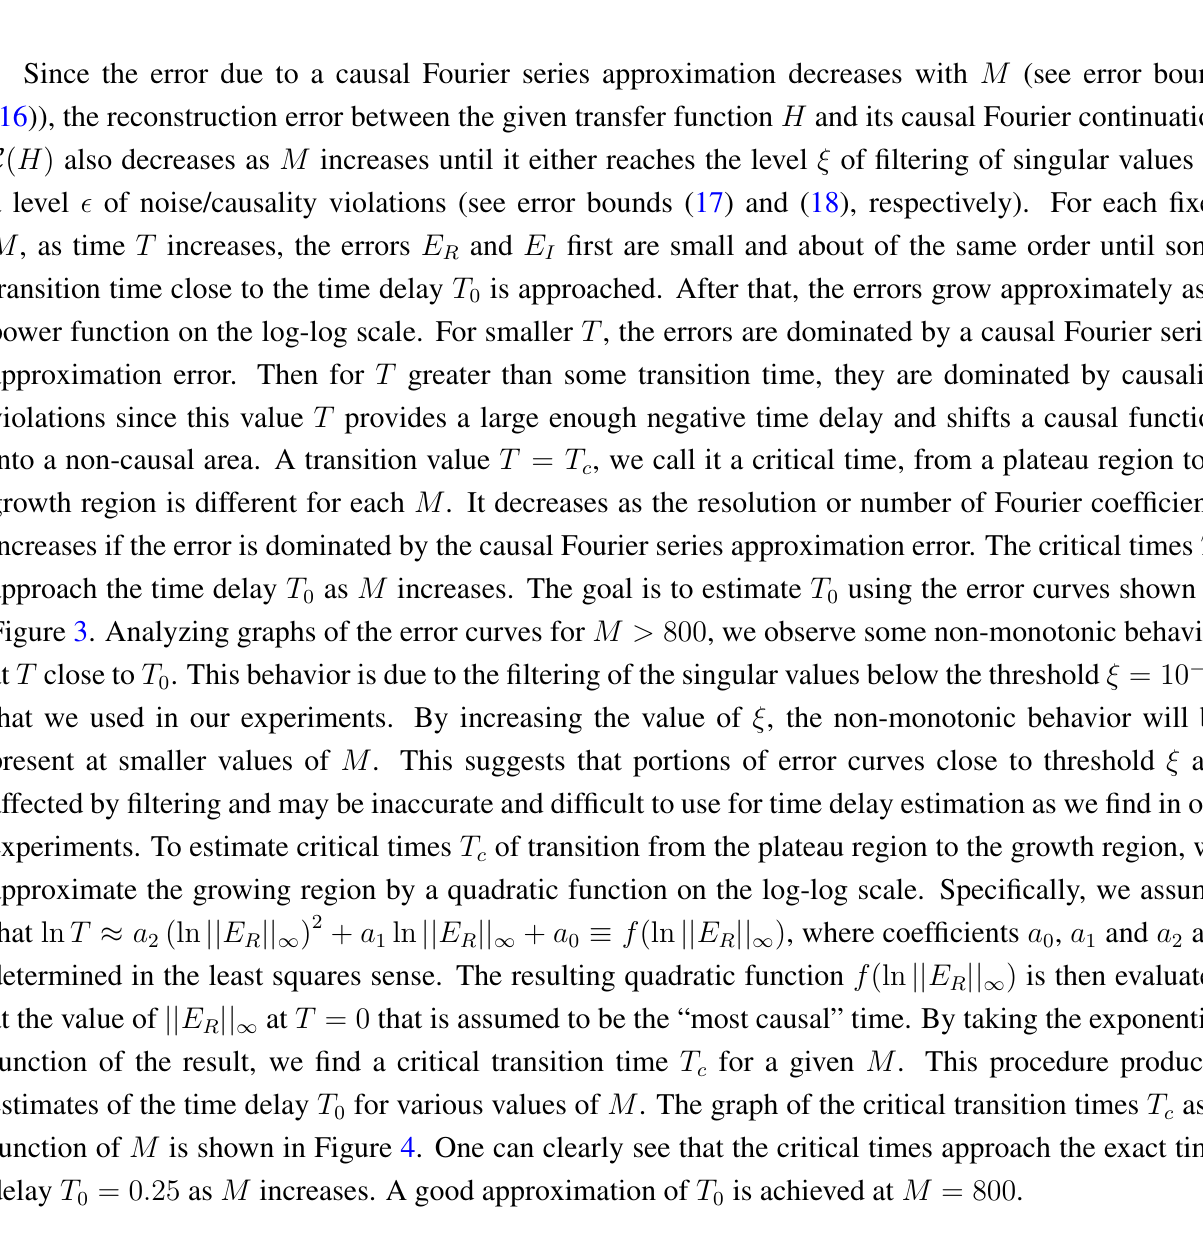
Figure 3. Evolution of the reconstruction error || E example. The dashed line corresponds to the exact delay T